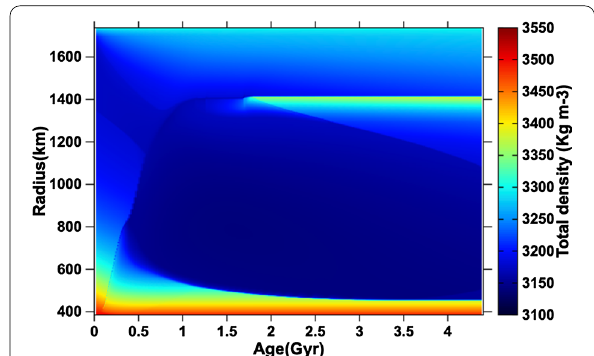
Fig. 9 The evolution of distribution of the total density ρ total calculated for the reference